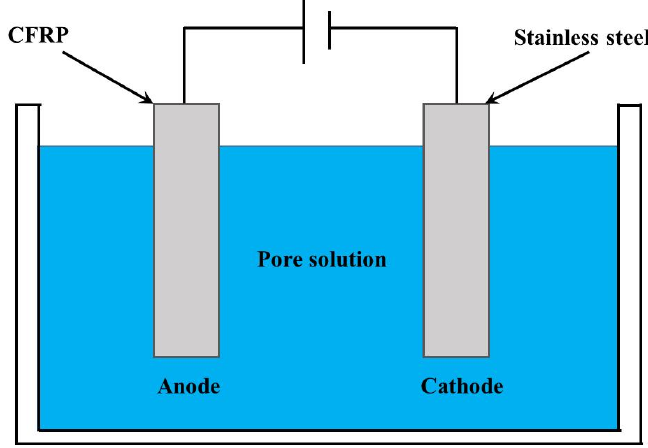
Figure 2. Schematic view of the simulated impressed current cathodic protection (ICCP) system.